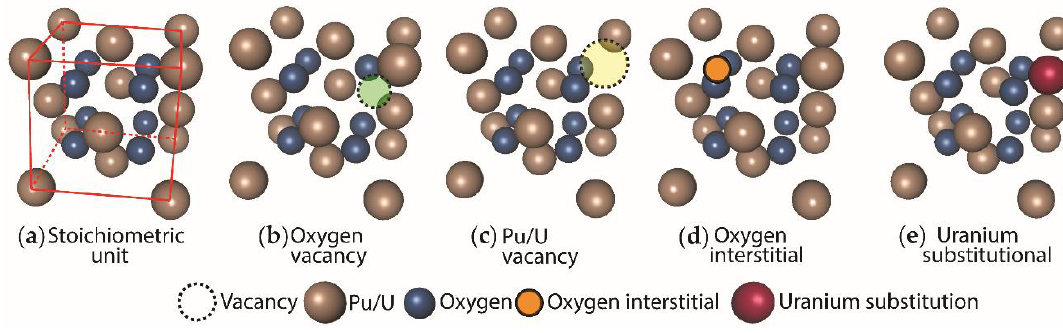
Figure 2. Unit cell of PuO 2 or UO 2 with various defects.